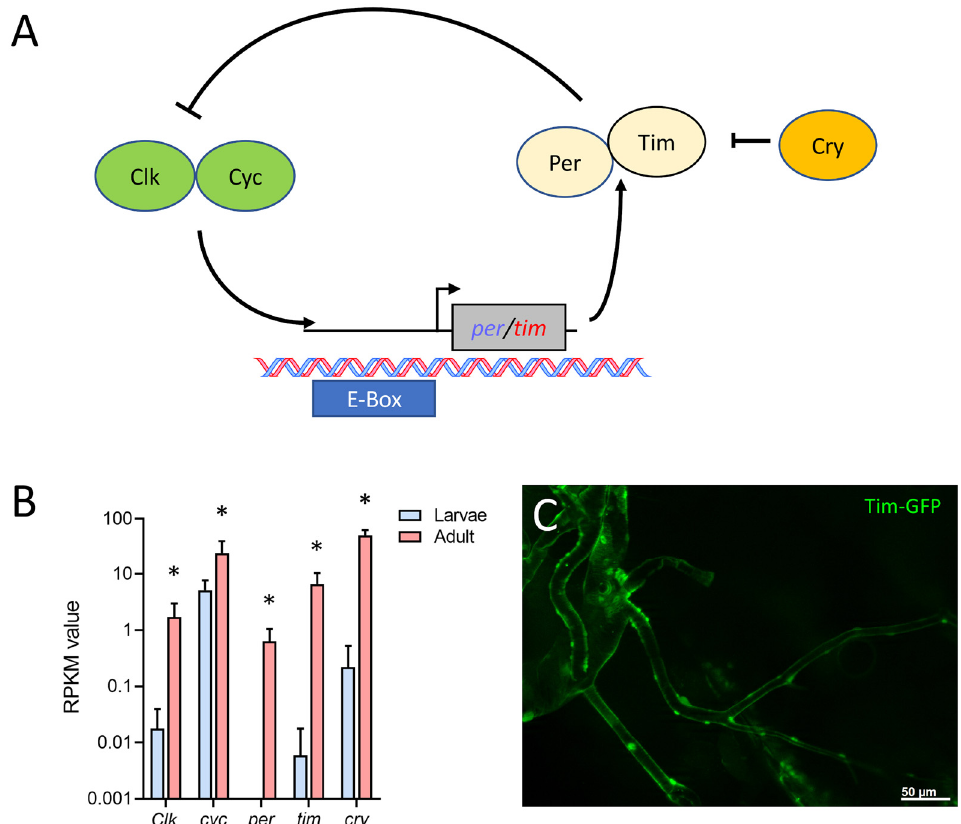
Figure 7. Adult tracheal cells express core components of the circadian clock. ( A ) Schematic overview of the circadian clock in Drosophila . ( B ) Normalized read count (RPKM) values of clock coding genes for Clock ( Clk ), cycle ( cyc ), period ( per ), timeless ( tim ) and cryptochrome ( cry ). Bars show mean with SD, n = 4. Asterisks indicate a differential gene expression based on the RNA-Seq analysis. ( C ) Microscopic confirmation of in vivo Tim expression in abdominal adult trachea.